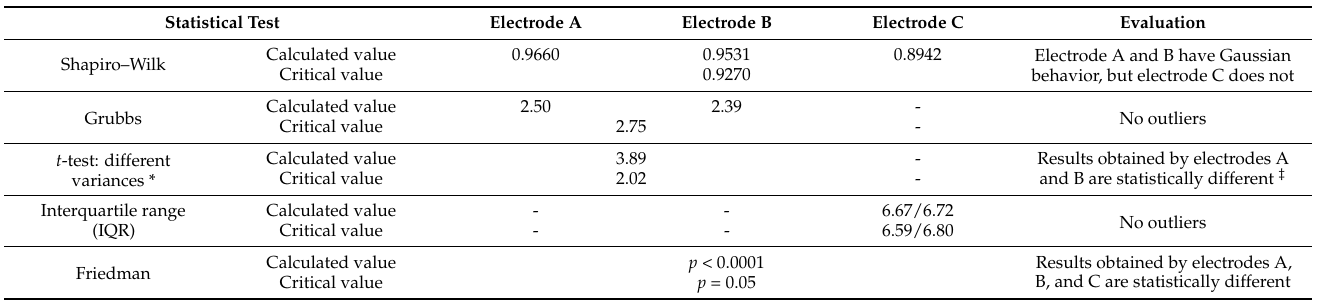
Table 8. Comparing results from electrodes A, B and